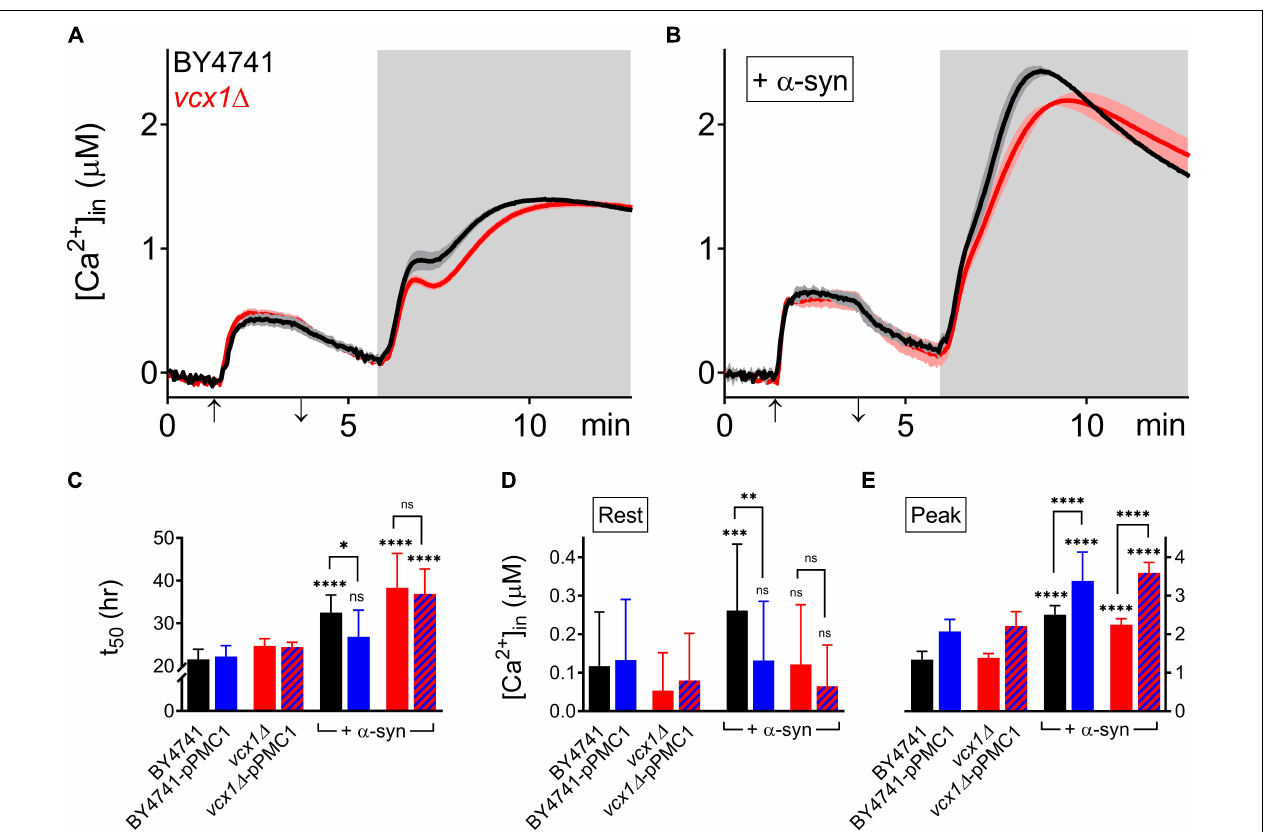
FIGURE 6 | α -Syn overexpression in VCX1 mutant strains. (A,B) Averaged Ca 2 + transient ± SEM (thin lines either side of the Ca 2 + transient trajectory) of BY4741 cells (black) and vcx1 (cid:49) cells (red) without (A) or with overexpression of α -syn (B) at 30 ◦ C. Cells were initially perfused with Ca 2 + -free starvation medium and then transferred to a 10 mM external Ca 2 + medium for 2 min (indicated by up and down arrow on X -axis). Thereafter, cells were briefly exposed to Ca 2 + -free intracellular medium prior to membrane permeabilization using Triton X-100 (indicated by light gray zone). (C–E) Comparison of t 50 (time to reach half-maximal OD 600 ) (C) , Rest [Ca 2 + ] ([Ca 2 + ] in value determined at the end of the Ca 2 + -free period prior to permeabilization) (D) and Peak [Ca 2 + ] (peak amplitude of the Ca 2 + release transient following permeabilization) (E) for VCX1 mutant strains without and with α -syn overexpression. Bar graphs depicting mean ± SD. The statistical significance was assessed using one-way ANOVA with Bonferroni posttest. Unless otherwise indicated by connecting bar, differences were tested with respect to the control strain (without α -syn expression). ns (not significant) P > 0.05; ∗ P ≤ 0.05; ∗∗ P ≤ 0.01; ∗∗∗ P ≤ 0.001; ∗∗∗∗ P < 0.0001. Mean and P -values are listed in Tables 4 , 5